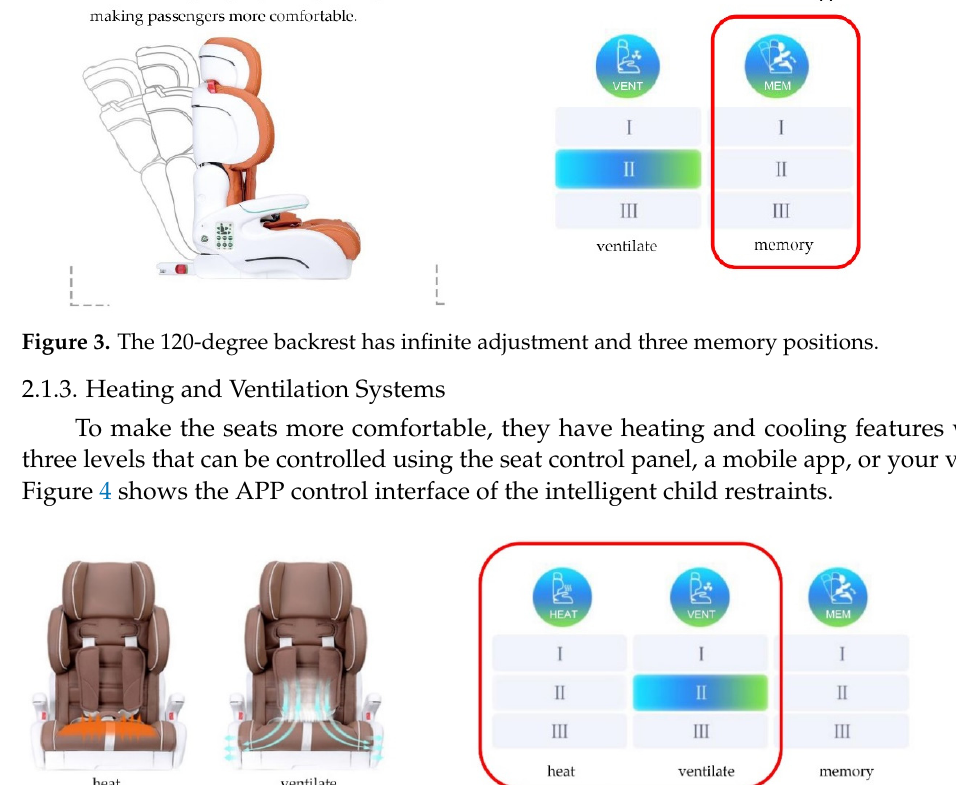
Figure 2. Control Isofix automatic extension with the control panel on the seat. 2.1.2. The 120-Degree Backrest Has Infinite Adjustment and Three Memory Positions